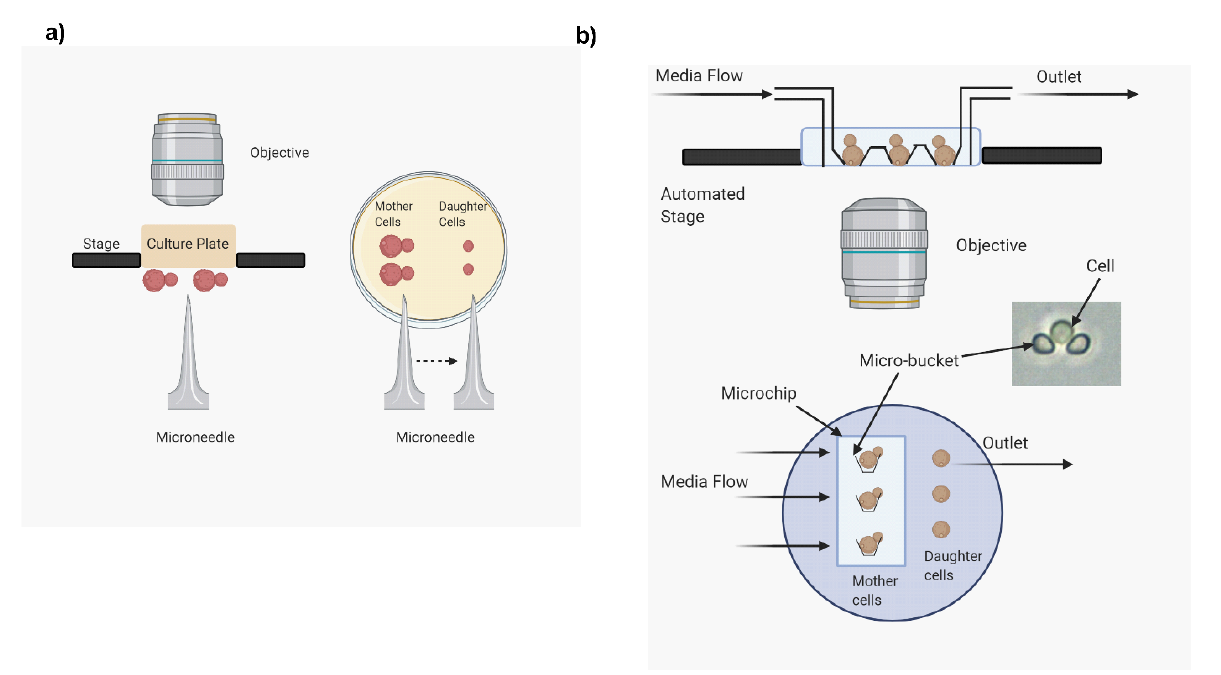
Figure 2. Methods for analyzing replicative life span (RLS). Two methods associated with analyzing RLS in yeast are described here. ( a ) Microdissection method: requires more manual interventions; ( b ) microfluidics method: automated and high throughput. The images were prepared with the use of biorender.com.